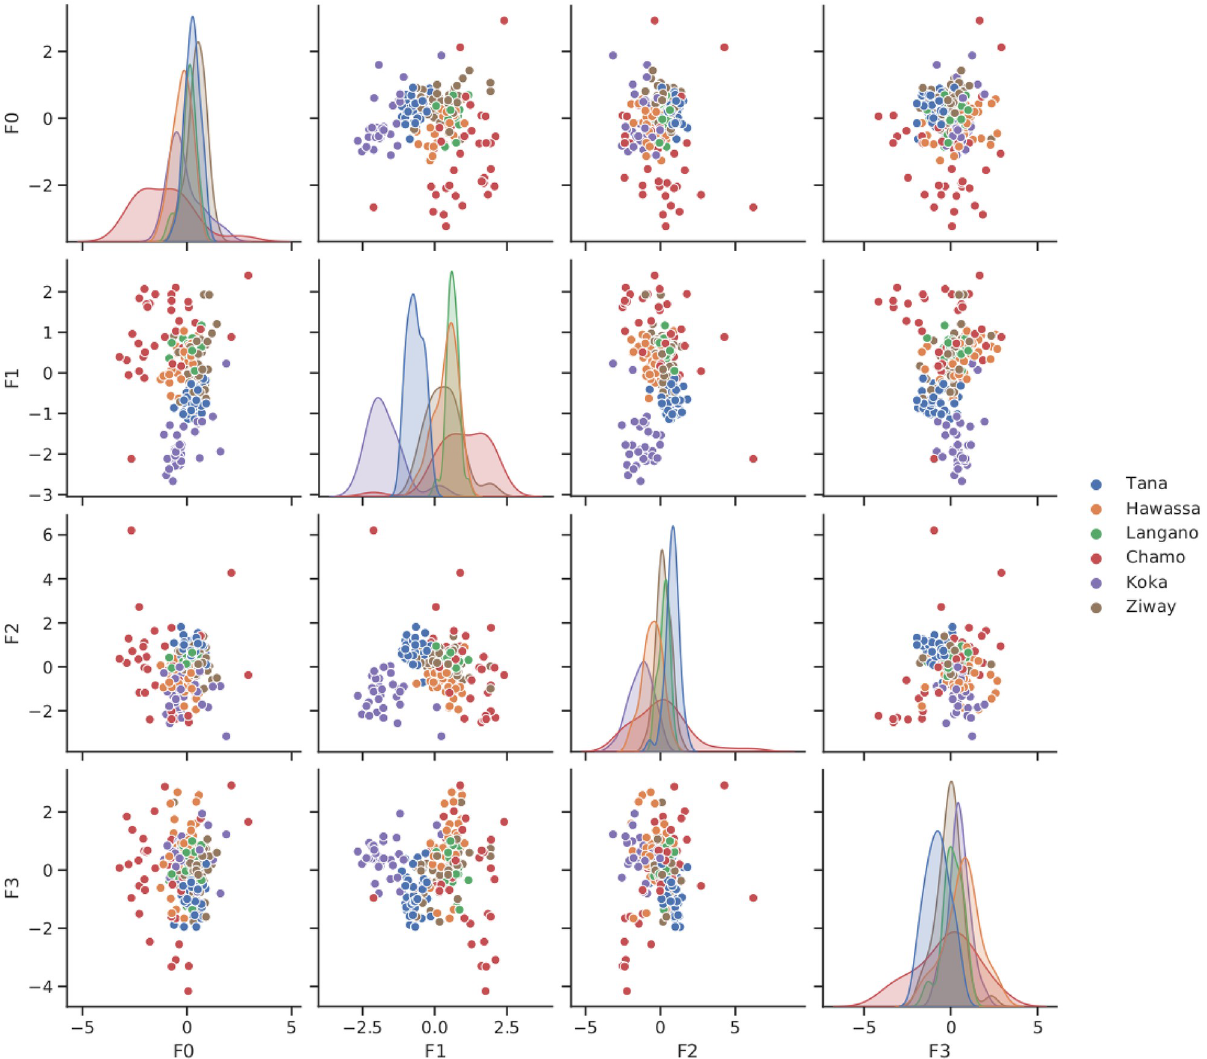
Fig 5. Visualization of GP-LVM projections. A scatter plot matrix provides pairwise impressions of the latent dimensions F0 to F3. Coloring by lake shows that dimension F0 separates lake Chamo from the other lakes while dimensions F1 and F2 show distinct values for lakes Koka and Tana.